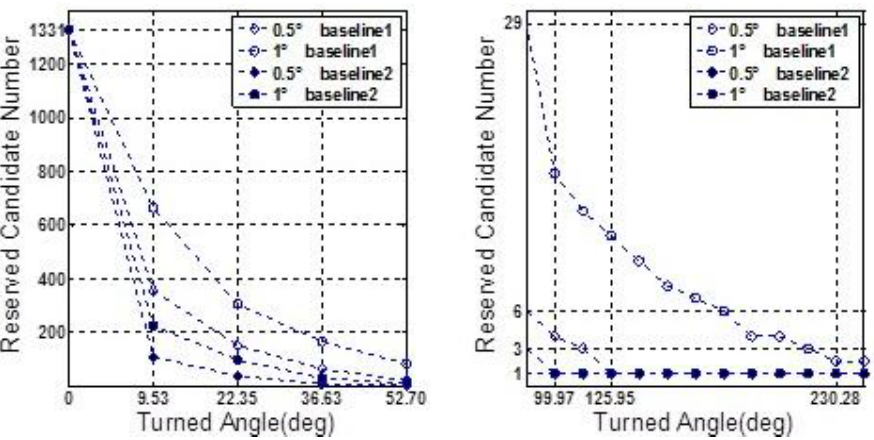
Figure 17. Comparison of shrinking efficiencies of Baselines 1 and 2.